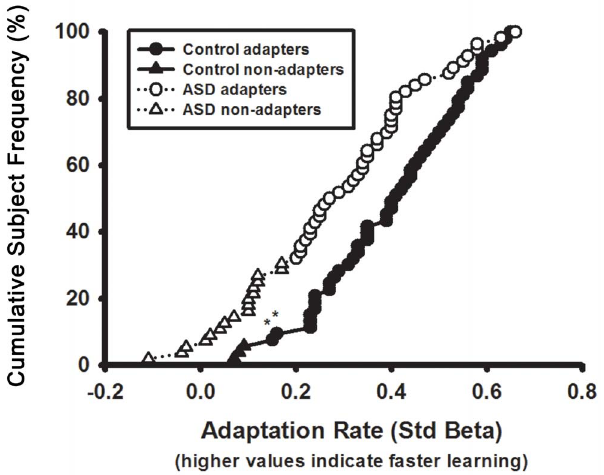
manual testing (Figure 5A; r 56 = .39, p , .01). Neither of these relationships were significant for healthy controls (time to completion: r 37 =.22, p = .19; dropped pegs: r 37 = .18, p = .30). Increased amplitude variability in subjects with ASD showed a modest non-significant relationship with the number of dropped pegs, (Figure 5B; r 40 = .30, p= .03). Amplitude variability was not related to manual motor completion time in subjects with ASD (r 56 = -.04, p= .79). The relationships between saccade amplitude variability and manual motor indices were not significant for